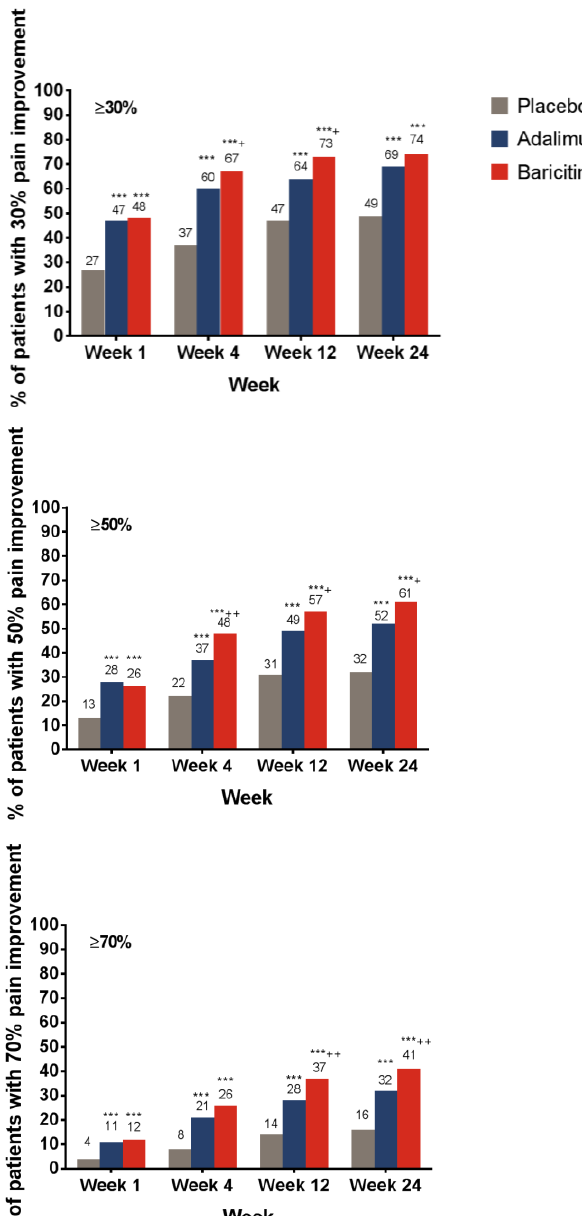
Figure 1. Percentage of patients who achieved pain relief thresholds from baseline, as measured by the pain VAS. *** p ≤ 0.001 vs. placebo; † p ≤ 0.05; †† p ≤ 0.01, ††† p ≤ 0.001 vs. adalimumab. Abbreviations: VAS = visual analog scale. Number of respondents who answered the pain question by week: placebo, n = 481 at Week 1 and n = 483 at all other weeks; adalimumab, n = 325 at Week 1 and n = 327 at all other weeks; baricitinib, n = 482 at all weeks.